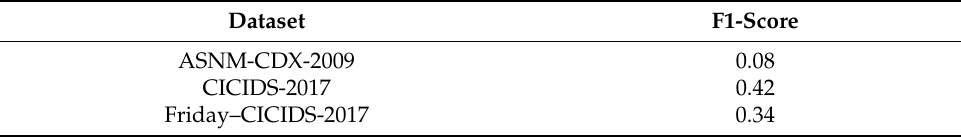
Table 6. Long Short-Term Memory results comparison for all datasets.